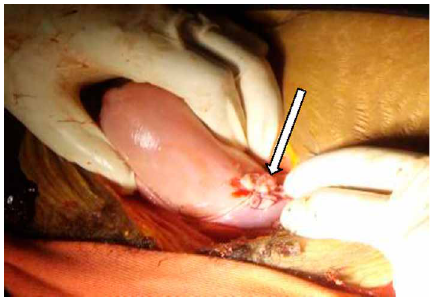
Figure 3: Stump (arrow) of the resected rudimentary horn after resection